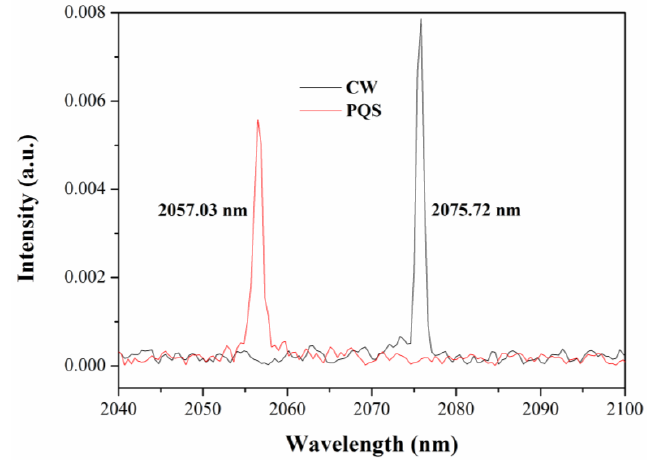
Figure 6. The output wavelengths of the Tm,Ho:LuVO4 laser in CW and PQS mode Operations. A slit scanning beam profiler (BP109-IR2, Thorlabs Inc., Newton, NJ, USA) was used to acquire beam quality factors of Tm,Ho:LuVO 4 laser. Output beam profiles of Tm,Ho:LuVO 4 laser were measured, and 2D and 3D graphics are shown in Figure 7. In addition, beam quality factors M x 2 and M y 2 were measured to be 1.19 and 1.19, respectively, at approximately 1-W average output power from the PQS Tm,Ho:LuVO 4 laser.